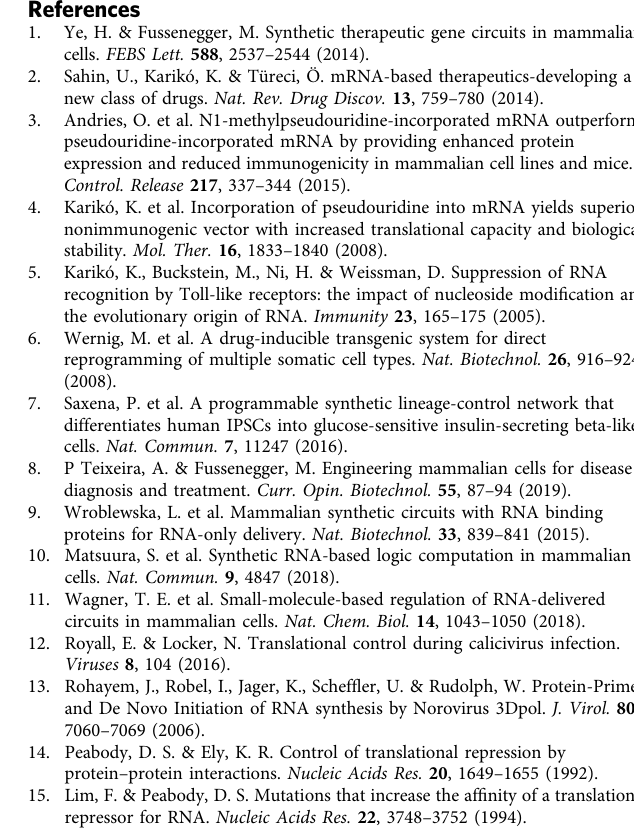
Fig. 8 Drug-mediated translational activation combining CaVT and the hetero-dimerization system. HeLa cells were co-transfected with hmAG1 mRNAs containing an MS2-binding motif (cap analog: A-cap, modi fi ed nucleosides: N1m Ψ or Ψ /5mC) and mRNAs that express tagRFP, DmrC-VPg(FCV), and MS2CP-1xDmrA or MS2CP(V29I)-1xDmrA. Then, A/C heterodimerizer was added. a Schematic diagram of drug-regulatable CaVT, which is composed of MS2CP-1xDmrA and DmrC-VPg(FCV). MS2CP-1xDmrA binds to the MS2 binding motif of target mRNAs. In the absence of A/C heterodimerizer,